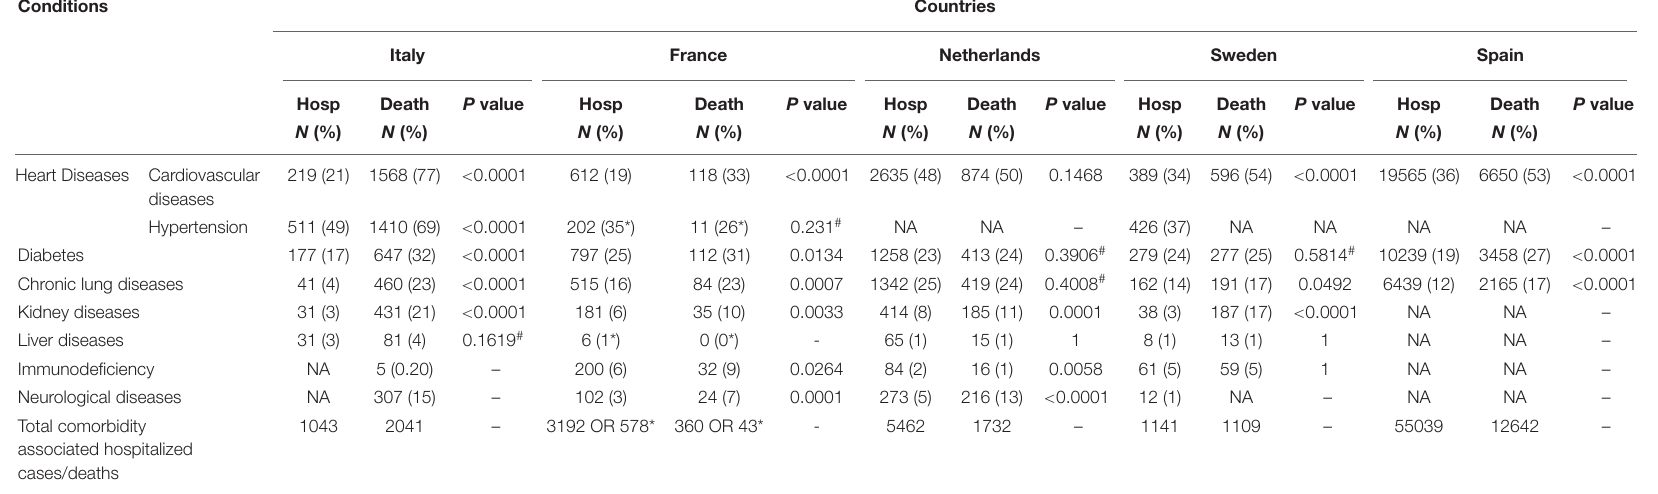
The table represents country-wise COVID-19 patients with associated comorbidities in numbers (N) as well as percentage (%). All the percentage values are rounded up. One patient may belong to several other groups. For France, Italy, and Sweden the hospitalized patients’ data was available and considered for intensive care unit (ICU) patients only. While for Spain the hospitalized plus ICU patients and for Netherlands patients admitted in hospital was considered in the category of hospitalized patients. The count of patients with other than enlisted comorbidities presented in the original reports have not been included in the table but considered in the total. NA, Not available; Hosp., Hospitalized patients. (Timespan for country wise data: Italy- Hosp.-NA, death- 21/02/2020–23/04/2020; France- 16/03/2020–21/04/2020; ∗ France comorbidities data collected from 04/04/2020 (578 cases including 43 deaths); Spain-31/01/2020–22/04/2020; Netherlands-27/02/2020–10/04/2020; Sweden- 13/04/2020–19/04/2020). Neurological disease = Neuromuscular + neurovascular diseases; Cardiovascular disease = Ischemic heart disease + Atrial fibrillation + Heart failure + Stroke (Italy); Chronic lung disease = respiratory disease (spain)/ pulmonary disease (France); Immunodeficiency = HIV (Italy), Neurological disease = Dementia (Italy). # p > 0.05-not significant; p < 0.05-significant calculated from t-Test